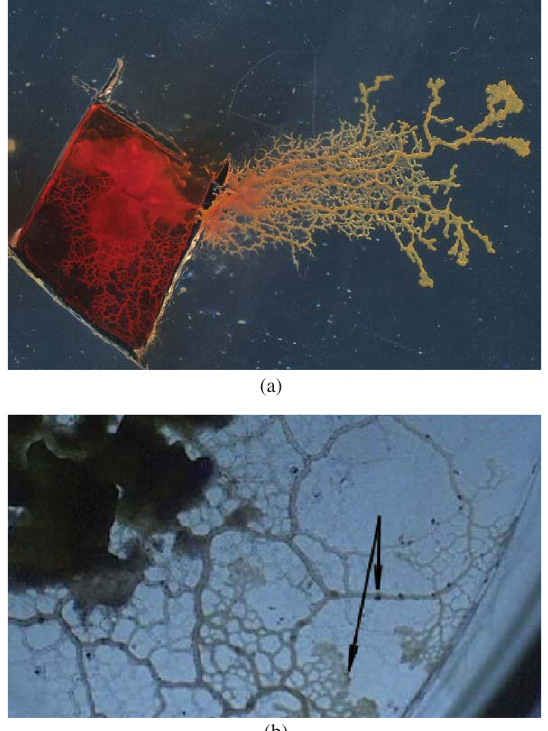
Fig. 14. Evidences of Physarum transport: (a) Propagating plas- modial localisation transports red dye outside the inoculation site. See details in [3]. (b) Protoplasmic network with clusters of silver spheres transported away from their source. Examples of two clus- ters are marked by arrows. (Colours are visible in the online version of the article;